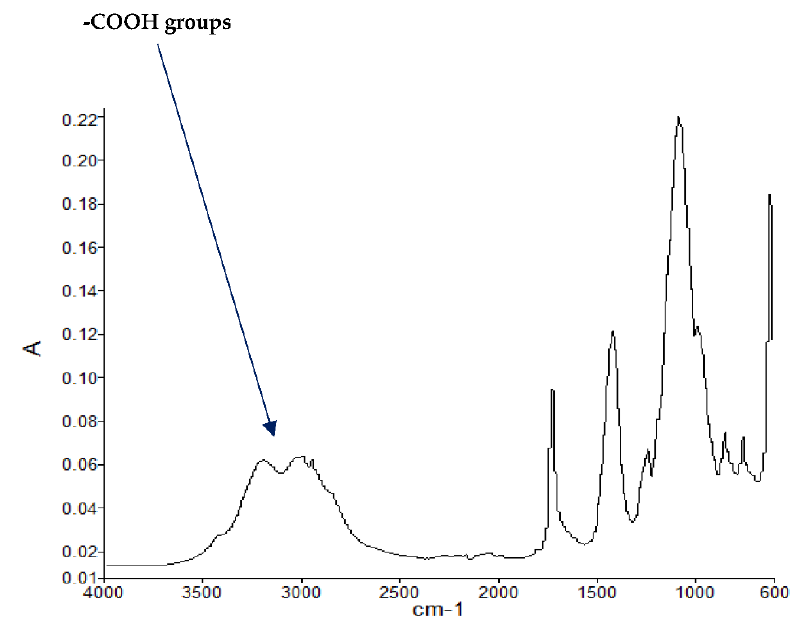
Figure 3. FT-IR spectrum of PMMA + DEpVBP (partially burnt sample).